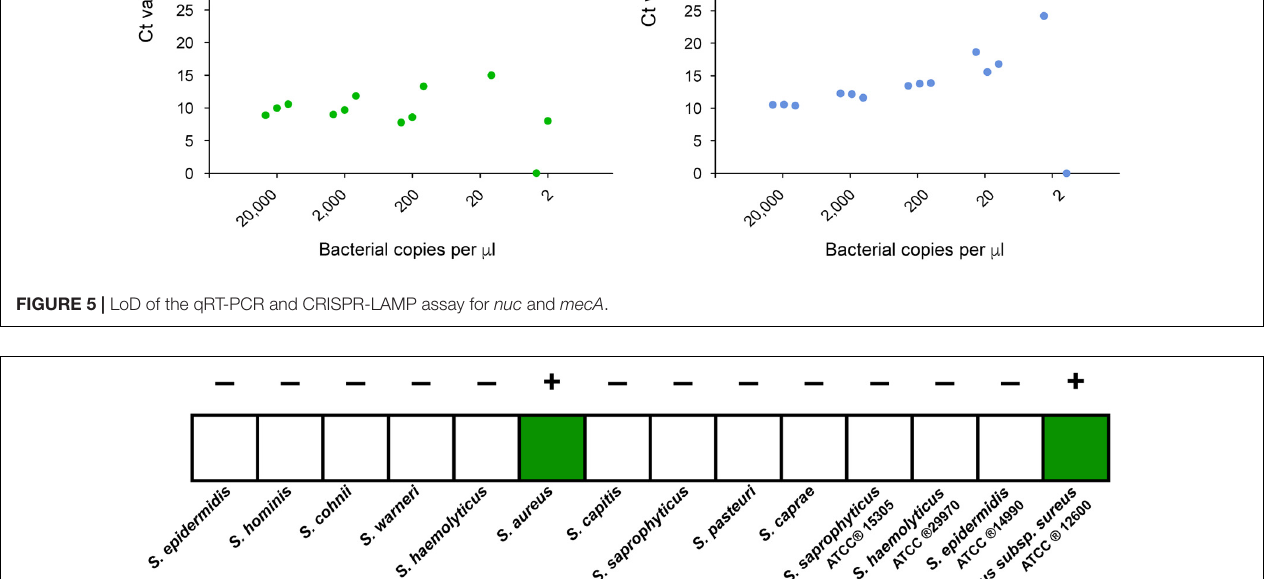
performed this assay for detecting nuc and mecA with serial dilutions. Green fluorescence was observed when the DNA sample was 2 × 10 5 , 2 × 10 4 , 2 × 10 3 , 2 × 10 2 , and 2 × 10 1 copies, which was referred to as a positive result. No green fluorescence signal was seen for a sample of 2 × 10 0 copies, one copy, and the no template control (NTC) ( Figure 4 ). The interpretation of the genetic results for bacterial identification are illustrated in Figure 4 .